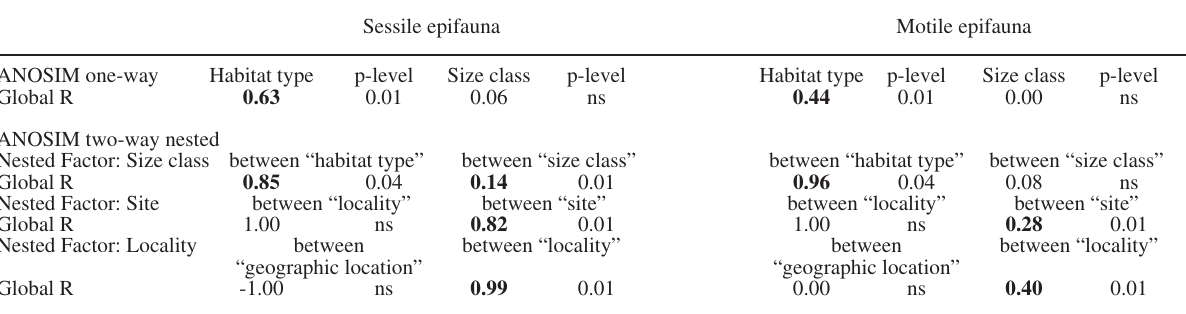
Table 3. – one-way and two-way nested analysis of similarity test (AnoSim) sessile and motile assemblages. habitat type discriminates sessile epifauna better than motile epifauna, whereas the size of the basibiont shows no influence. Both site and locality are significantly more discriminant for the former group than for the latter (see materials and methods for explanation of the tested